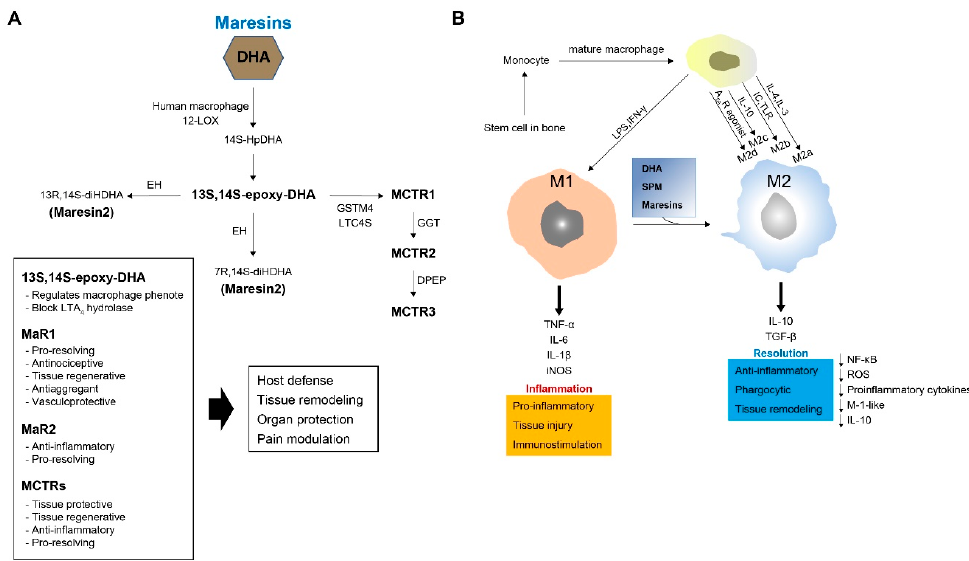
Figure 3. Synthesis and function of maresins (MaRs) and macrophages. ( A ) MaRs and MaR conjugates in tissue regeneration (MCTRs) biosynthesis. Human macrophage 12-LOX converts DHA to the 13S,14S-epoxy-maresin intermediate and hydrolase or soluble epoxide hydrolase is converted to MaR1 and MaR2, respectively. The MCTR biosynthetic pathway is initiated by lipoxygenation of 14S-HpDHA, converted by lipoxygenase activity to the 13S,14S-epoxy-maresin intermediate. MCTR1 is catalyzed by glutathione s-transferase mu4 (GSTM4) and / or leukotriene C4 synthase (LTC4S). MCTR1 is converted dipeptidase (DPEP) to MCTR3. ( B ) M1 and M2 polarization of macrophages. Bone